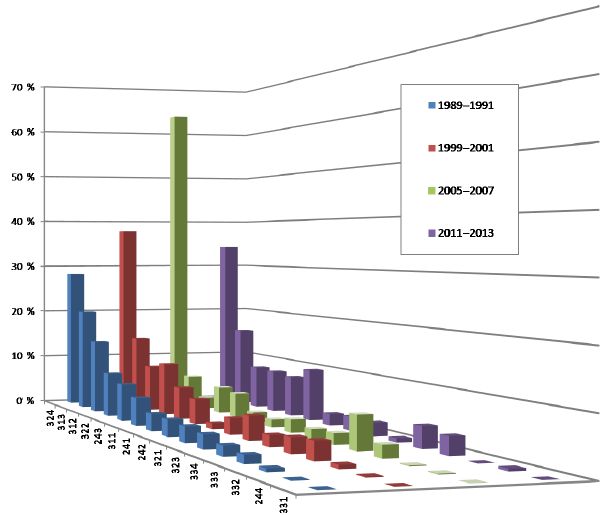
Figure 7. Classes of land use, as defined by the third-level hierar- chy of CORINE Land Cover, affected by wildfires expressed as a percentage as the ratio of burnt area (BA) affecting each CLC class over the total BA for each